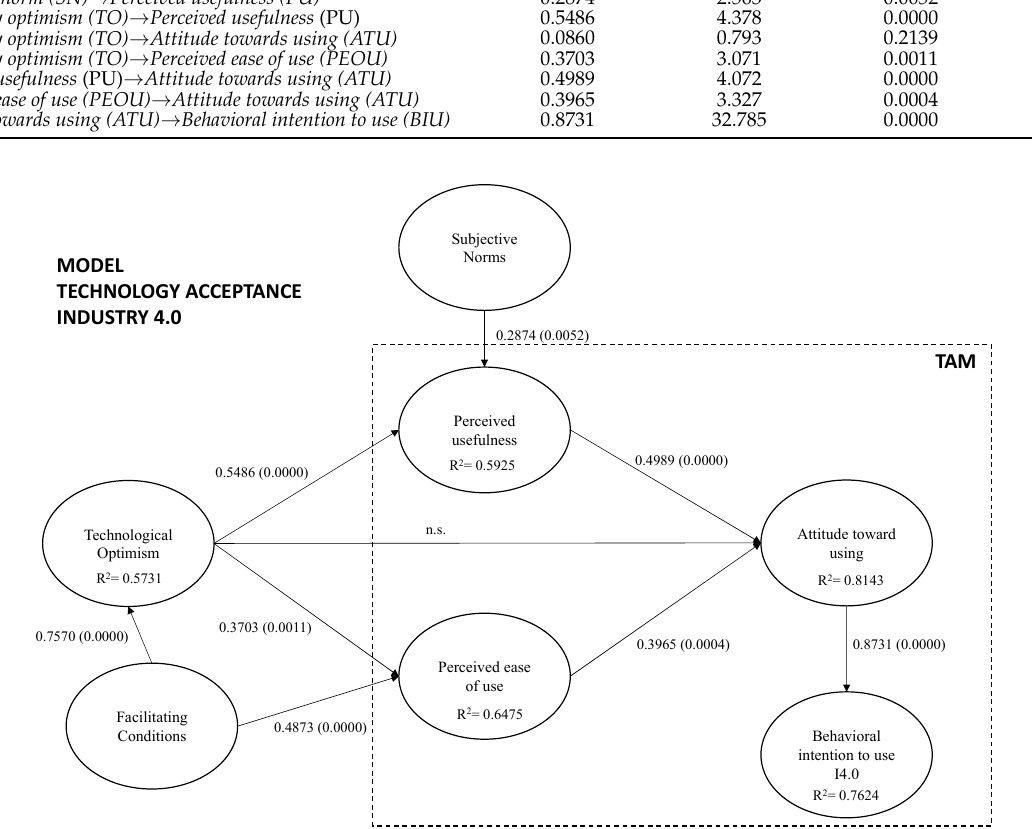
Figure 2. Resulting research model. Dashed arrow shows nonsignificant paths.